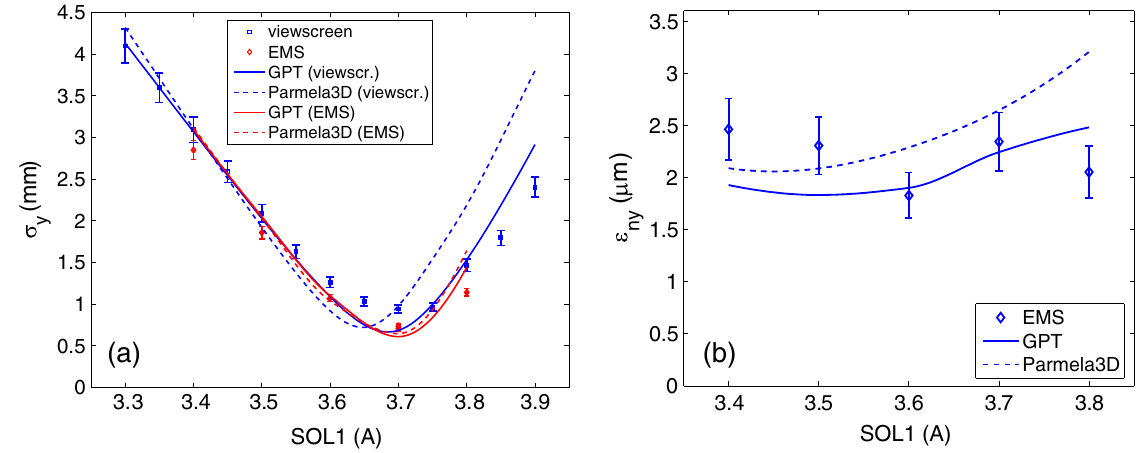
FIG. 17. (Color) Comparison of vertical rms beam size (a) and normalized rms emittance (b) at the location of the measurement z ¼ 1 : 244 m vs solenoid excitation current for 80 pC